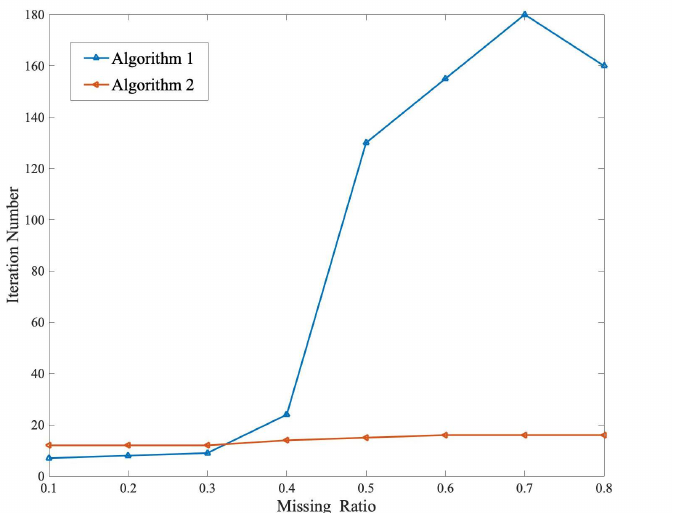
Figure 5. The iteration number comparison of Algorithms 1 and 2 under different missing